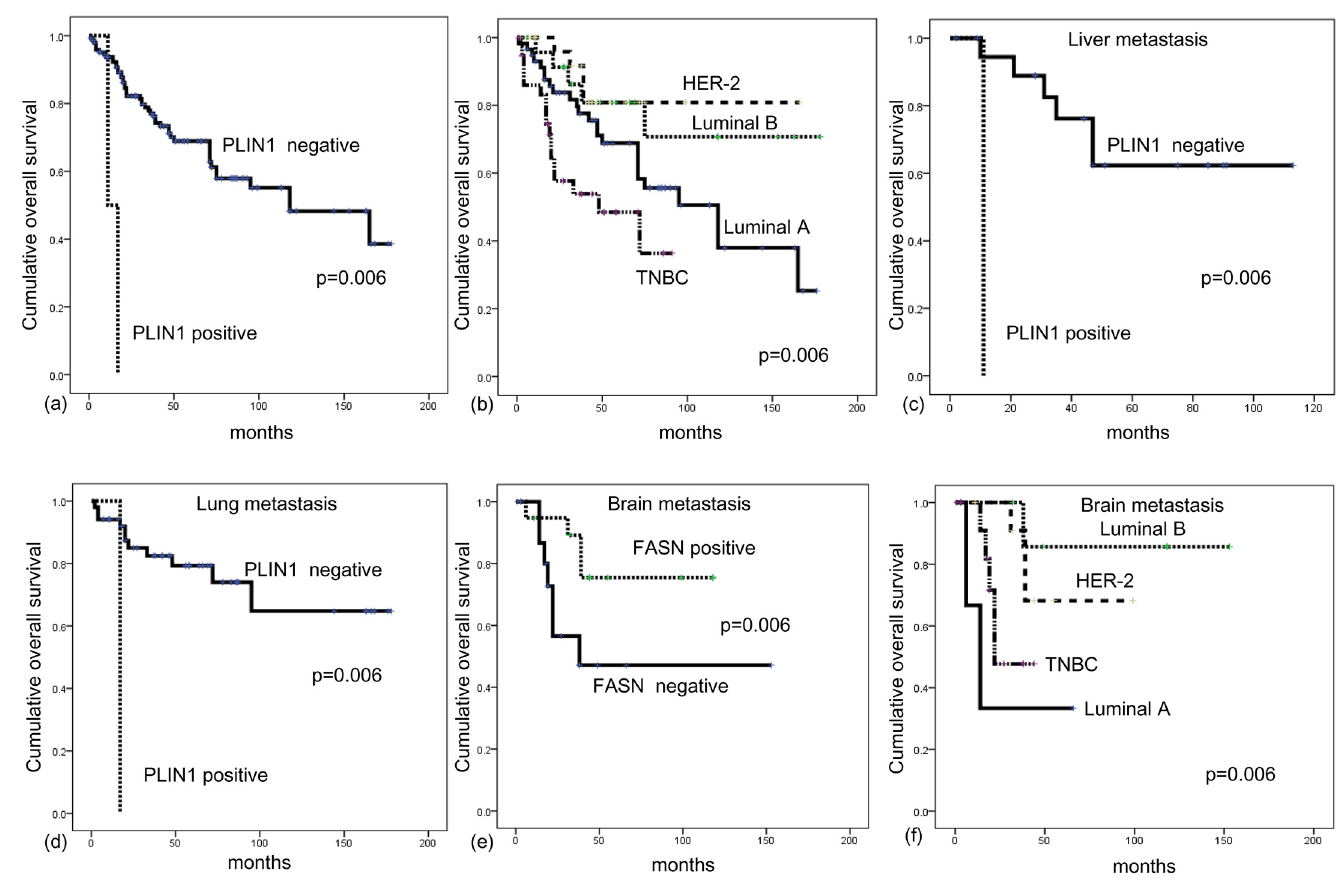
Fig 3. The impact of expression of lipid metabolism related proteins in metastatic breast cancer (a, b), liver metastasis (c), lung metastasis (d) and brain metastasis (e, f).